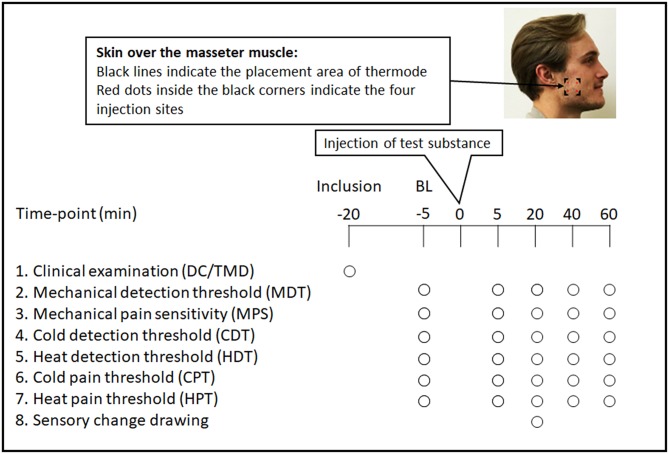
Flowchart showing the experimental protocol, and showing the time points in minutes and the order for every registration: inclusion examination, baseline (BL) and experimental assessments of mechanical detection threshold (MDT), mechanical pain sensitivity (MPS), cold detection threshold (CDT), heat detection threshold (HDT), cold pain threshold (CPT), heat pain threshold (HPT), and drawing of sensory change as well, in 18 healthy males. Written consent to publish image was obtained.